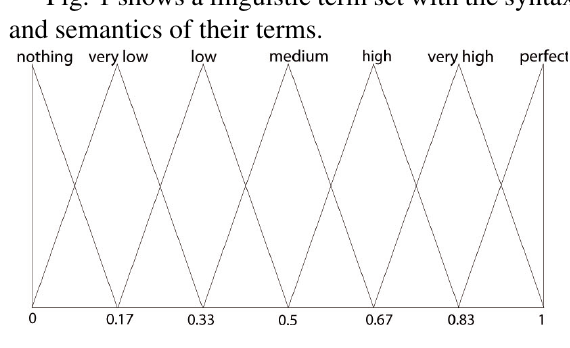
Fig. 1. A seven-term set with its